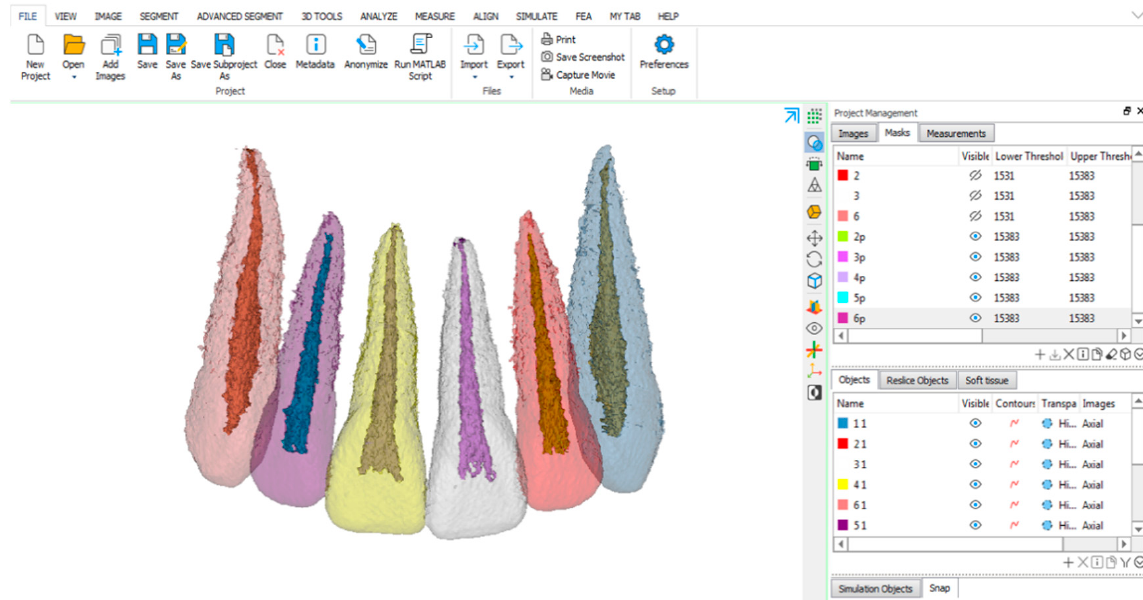
Figure 1. A screenshot from the Mimics software showing three-dimensional visualization of pulp and teeth of the maxillary anterior teeth in one of the cases.